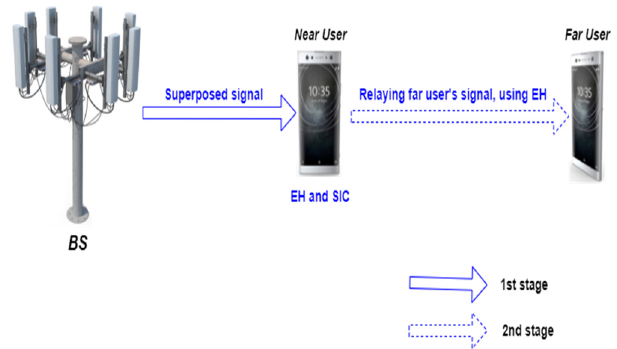
Figure 1. SWIPT with cooperative NOMA.